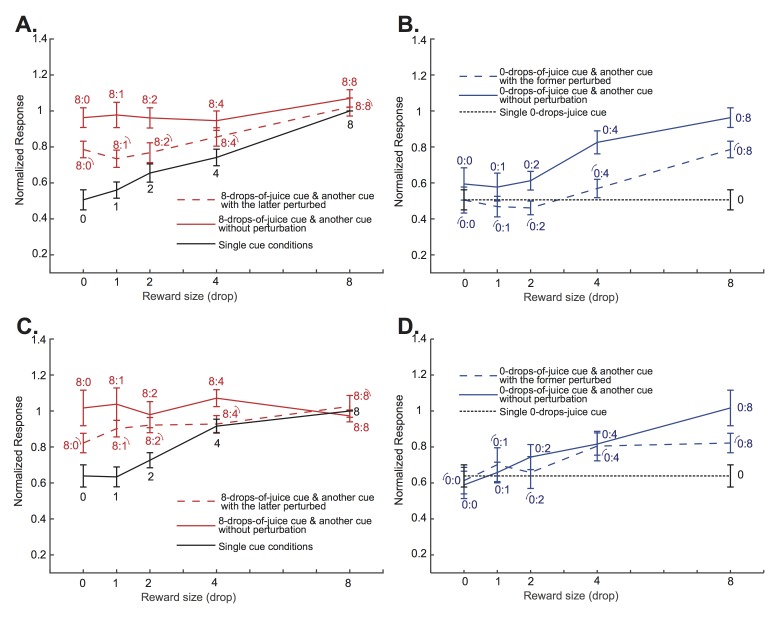
The modulation of the positively tuned neurons’ responses due to the attentional shift between the two cues depended on the difference between their associated values.(A) and (C) Similar to Figure 5A, but plotted separately for monkey D and G, respectively. (B) and (D) similar to Figure 5B, but plotted separately for monkey D and G, respectively.